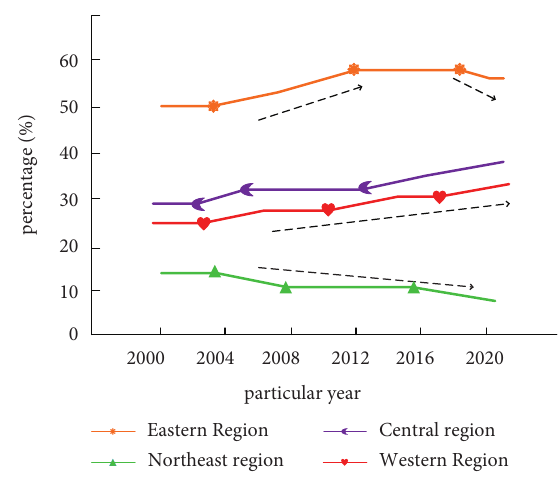
Figure 1: Proportion of GDP in each region.